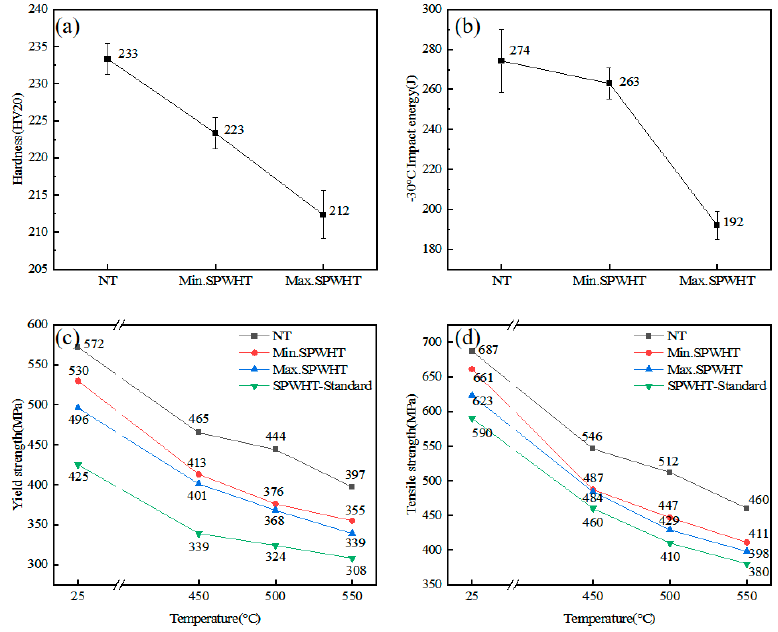
Figure 2. ( a ) Hardness, ( b ) − 30 °C impact energy, ( c ) yield strength, and ( d ) tensile strength of 2.25Cr1Mo0.25V steel before and after SPWHT.